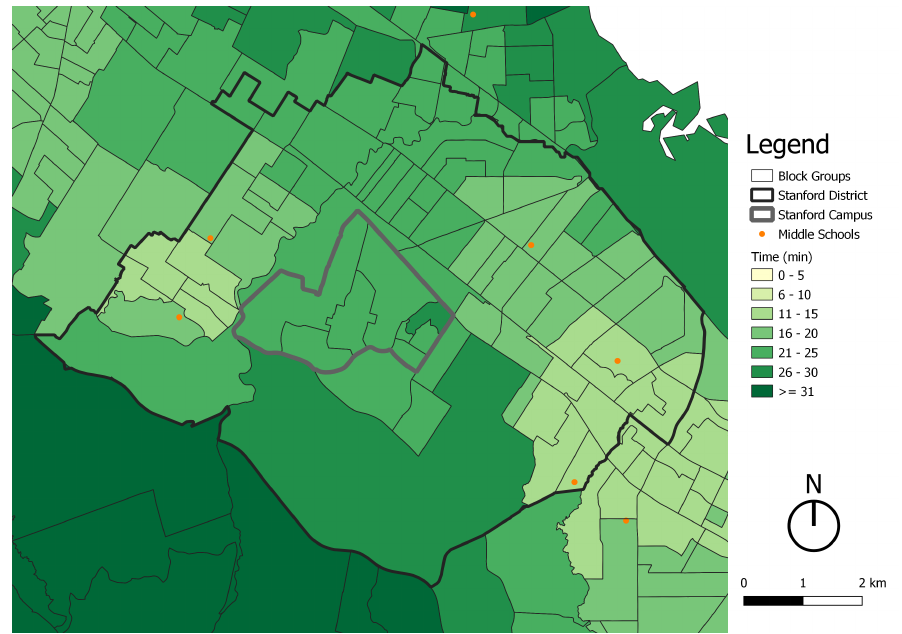
Figure 14. Stanford District average travel time to the 3 closest public middle schools by bicycle. Table 10. Accessibility level to middle schools traveling by bicycle per aggregation